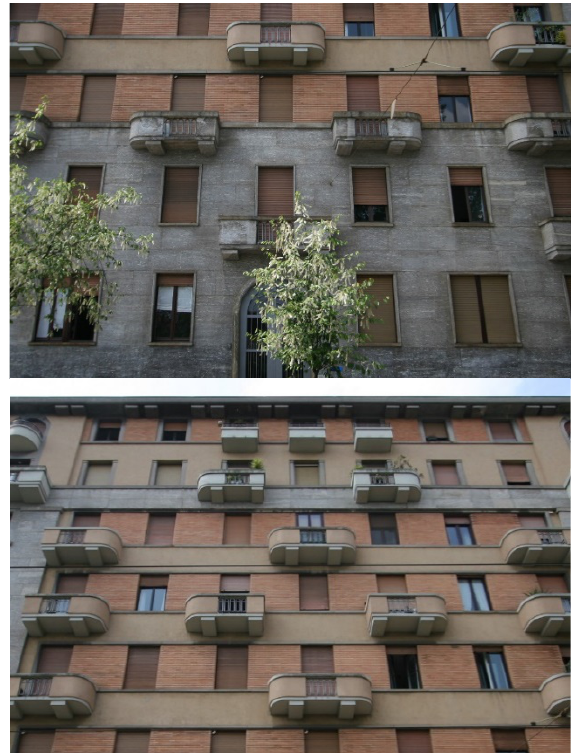
Figure 6 – Details of the lower (at top) and lower part of the Case Study 2’s façade.